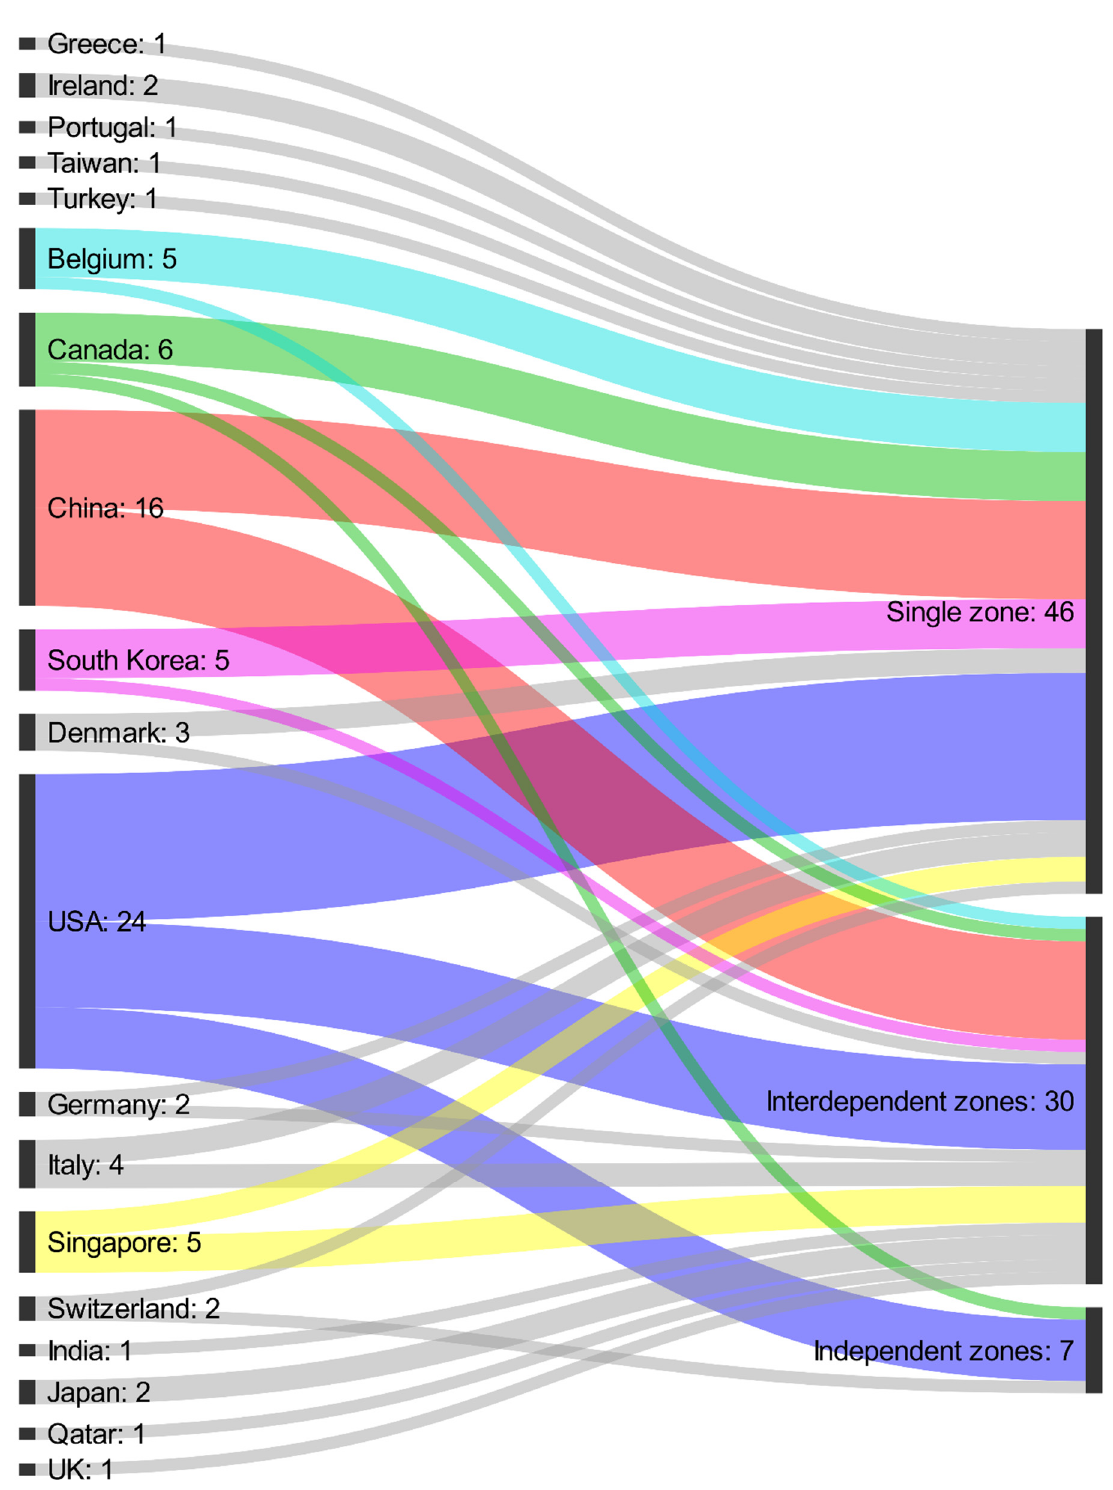
Figure 5. Sankey chart relating the country of affiliation of the first author (left) to the Tier 1, Tier 2 and Tier 3 categories.